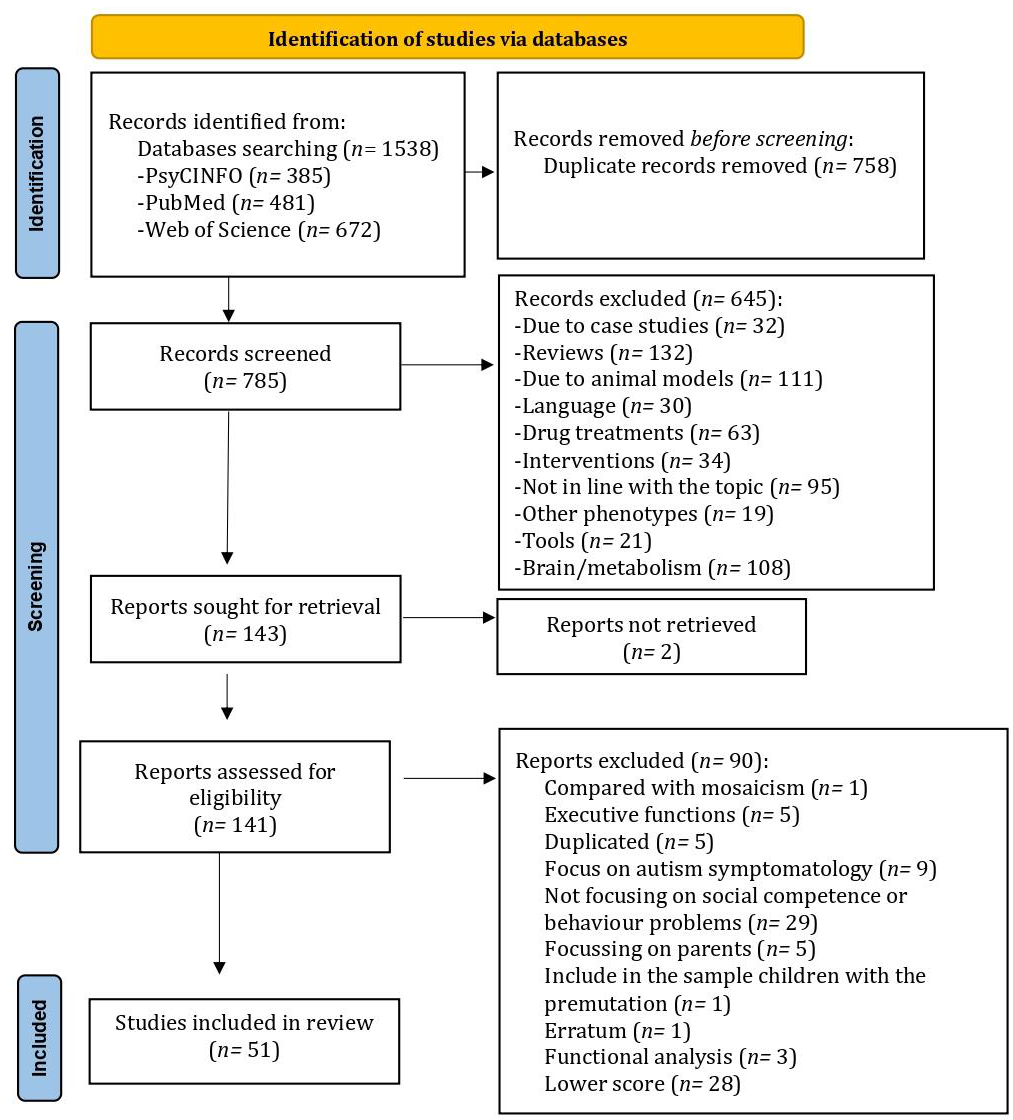
Figure 1. Based on PRISMA flowchart [74].